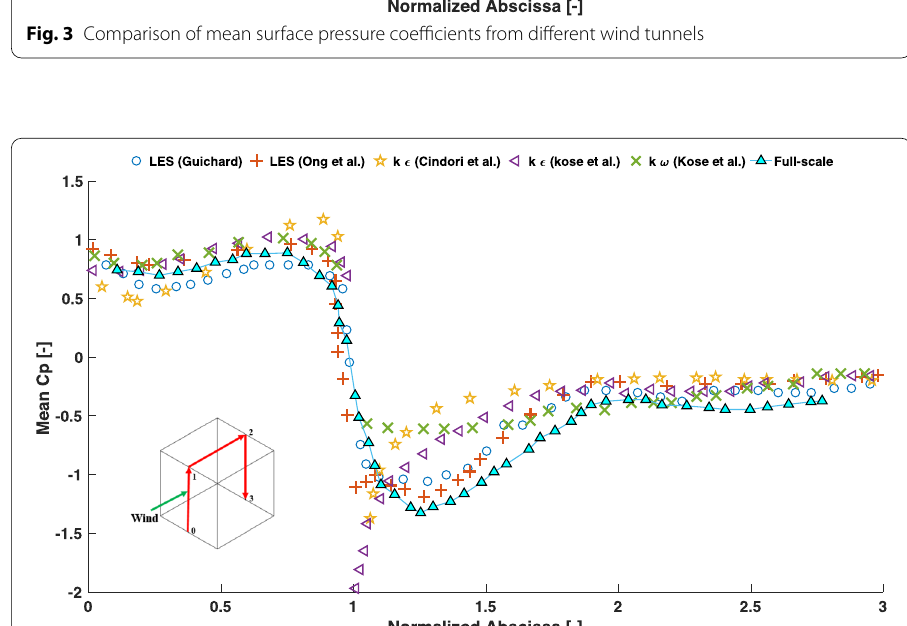
Fig. 4 Comparison of mean surface pressure coefficients obtained using RANS and LES simulations from the